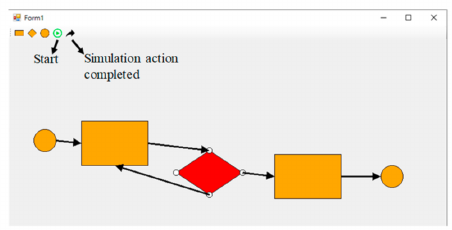
Figure 10. Sequence-control test.